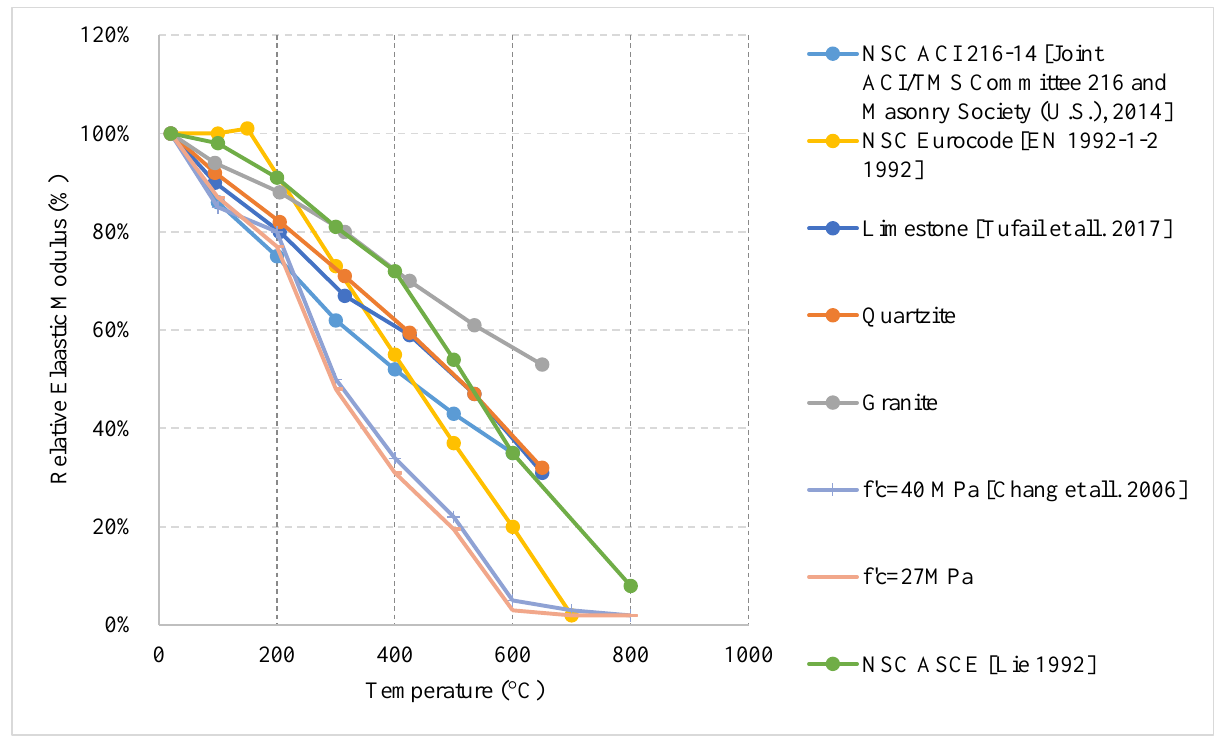
Figure 40. Relative Elastic modulus of different naturally cooled NSC mixes [4,5,46,48,119].